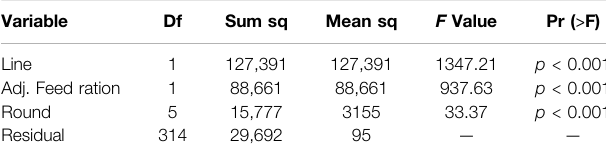
TABLE 4 | Analysis of variance for average larval weight. Df: degrees of freedom; Sum Sq: Sum of Squares; Mean Sq: Mean sum of squares. Variable